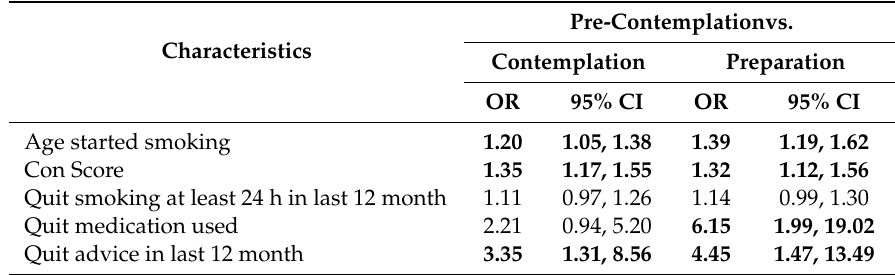
Table 3. Smokers in Pre-contemplation Stage versus Contemplation and Preparation Stage of Smokers, BOLD-Australia Study.